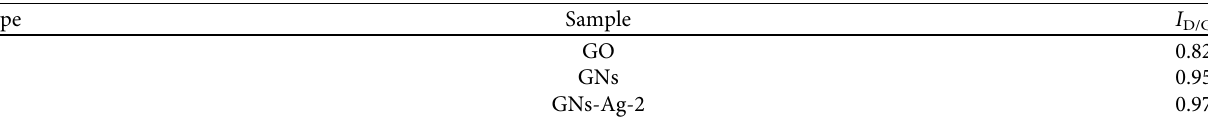
Table 3: The intensity ratio of the two peaks in the Raman spectrum of the sample.